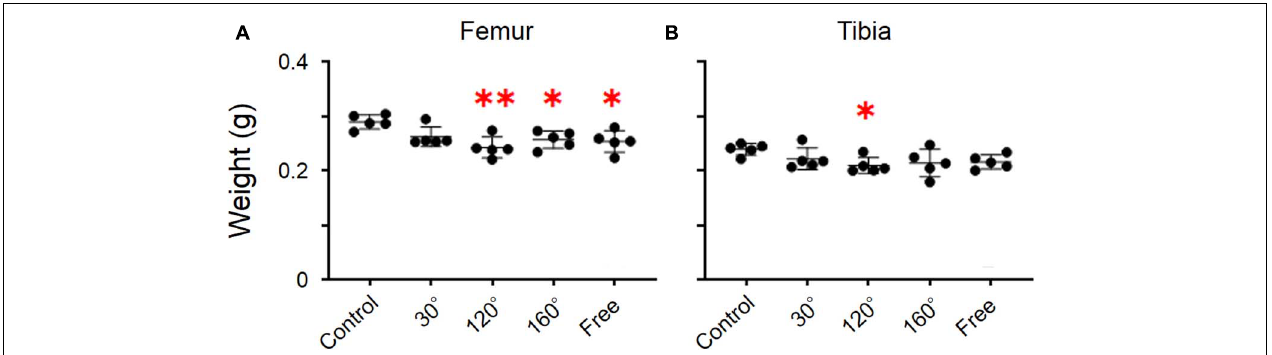
FIGURE 2 | Weights of the femur and tibia. (A) Femoral and (B) tibial weights [Mean ± standard deviation (SD), ∗ p < 0.05 vs. the control group, ∗∗ p < 0.01 vs. the control group, one-way analysis of variance (ANOVA)].